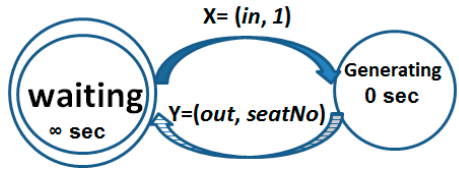
Figure 4. Passenger generator state diagram.